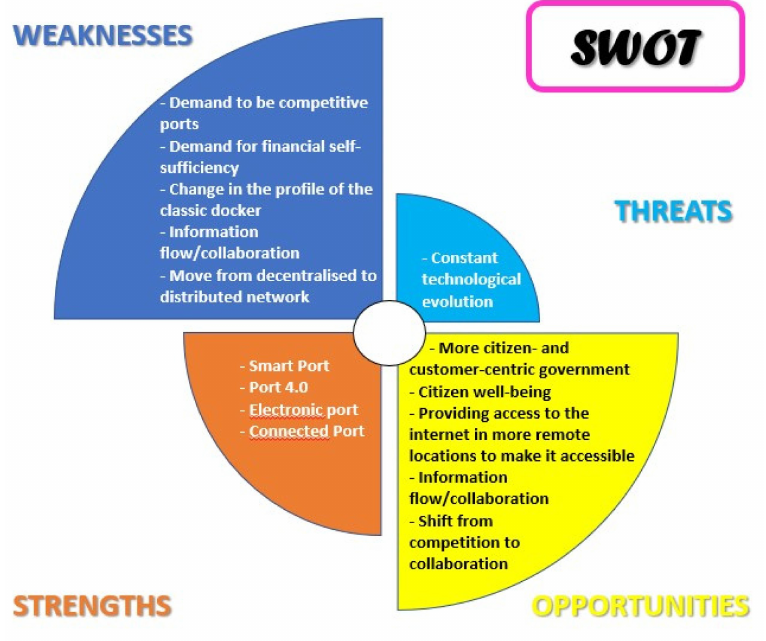
Figure 8. SWOT study of the environment. Source: own elaboration.